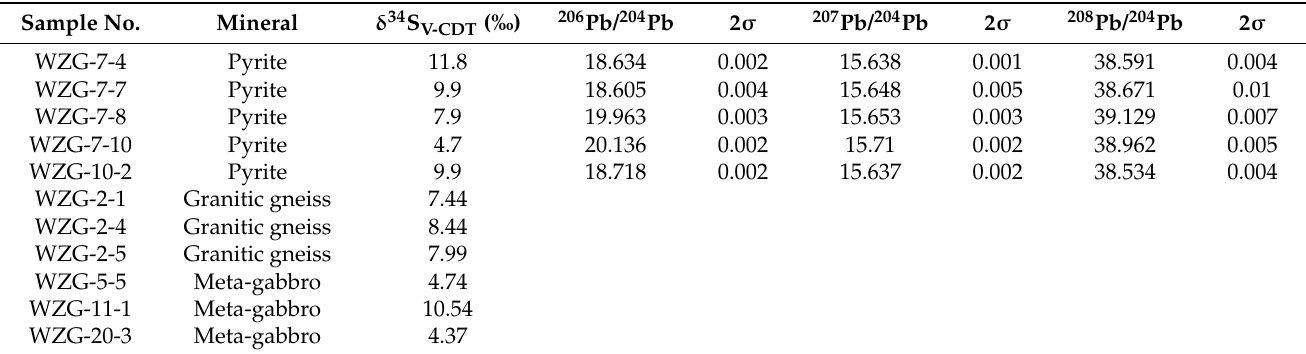
Table 4. Sulfur and lead isotopic compositions from the Weizigou deposit.